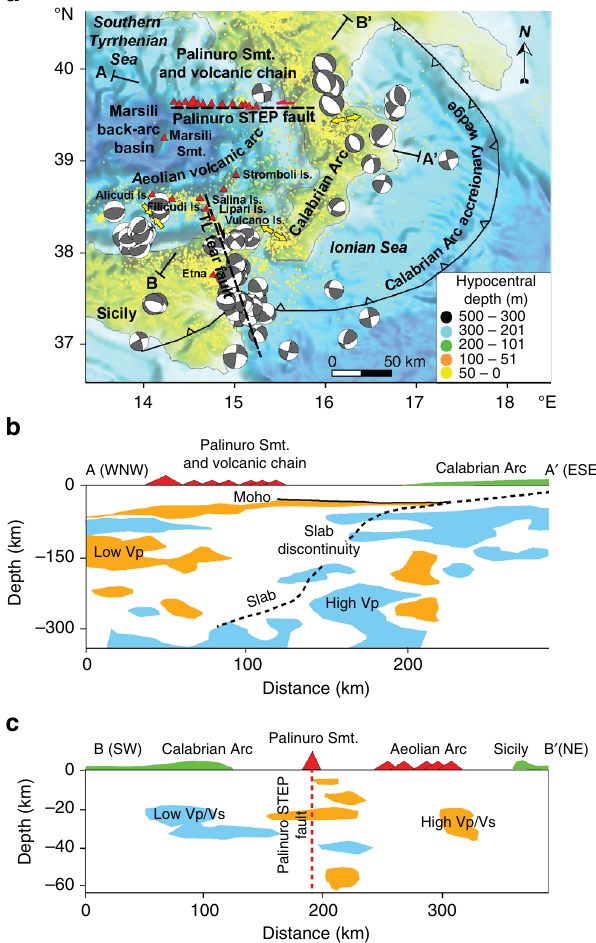
Fig. 1 Geodynamic setting of the Ionian Sea-Calabrian Arc subduction. a The Tindari Letojanni (TL) and Palinuro STEP fault system are from refs. 19, 20, 27 . The 2002 – 2017 earthquakes are from http://cnt.rm.ingv.it/ and the focal mechanisms of earthquakes with hypocentral depth < 30 km and Md > 4 are from http://www.eas.slu.edu/eqc/eqc_mt/MECH.IT/, respectively. b Location of the high and low Vp anomalies along the crustal pro fi le A – A ′ traced in a (data extracted from ref. 21 ); the top of the Ionian slab is also reported as dashed line. c Location of the high and low Vp/Vs anomalies along the crustal pro fi le B – B ′ traced in a (data extracted from ref. 22